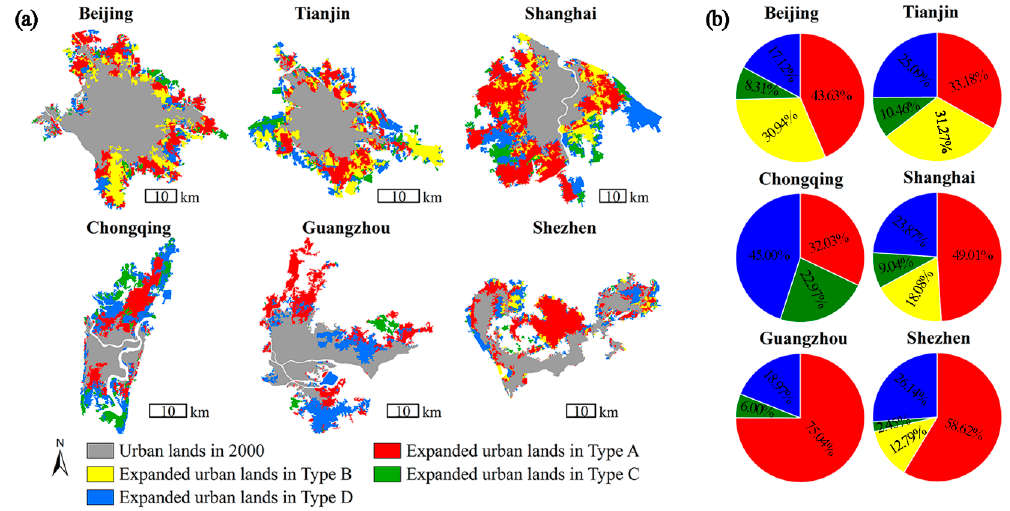
Figure 6. Urban land expansion types of China’s megacities: ( a ) Distributions and ( b ) proportions.